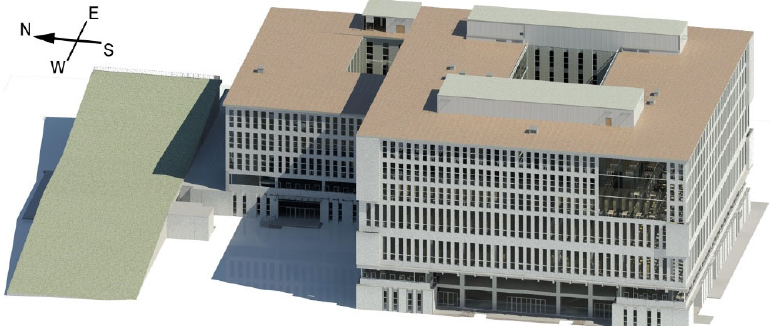
Figure 2. Building information model for the library at the Nanjing Forestry University.